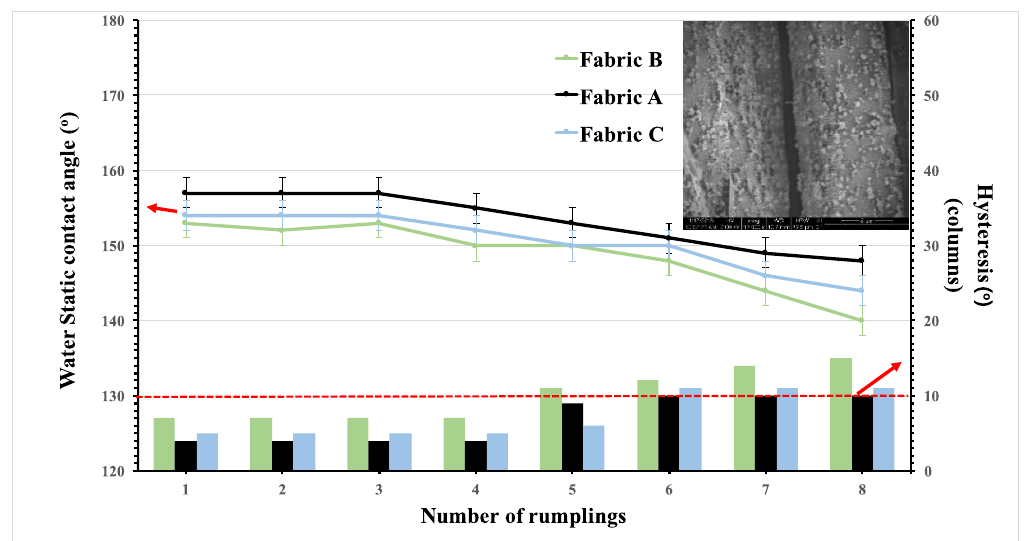
Figure 4. Stability against rumpling for the three different fabrics. Fabric A exhibits the highest durability against rumpling. On the right axis hysteresis is shown. The red dashed line is the Hysteresis upper limit for superhydrophobicity. An SEM image of fabric A after rumpling the fabric eight times